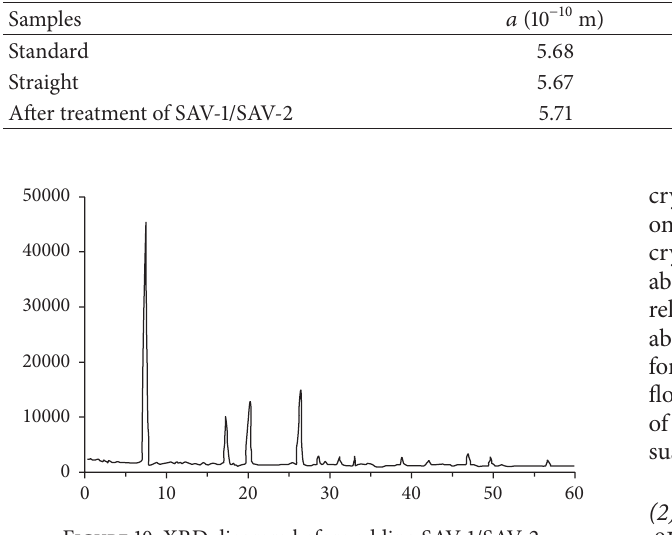
Table 3: Unit cell constant of CaSO